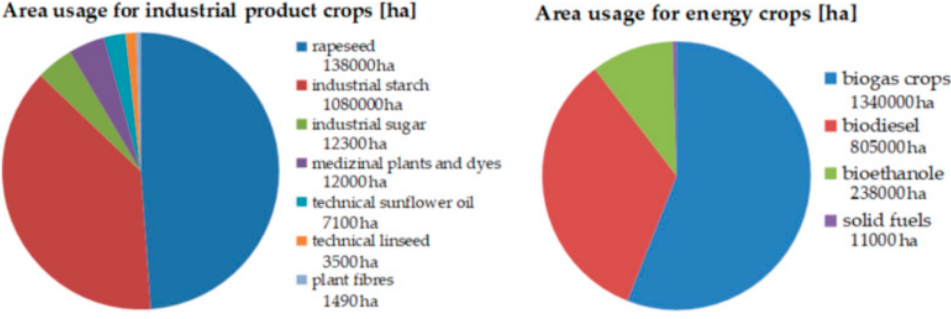
Figure 6. Area usage for industrial and energy crops in Germany in hectares [114].